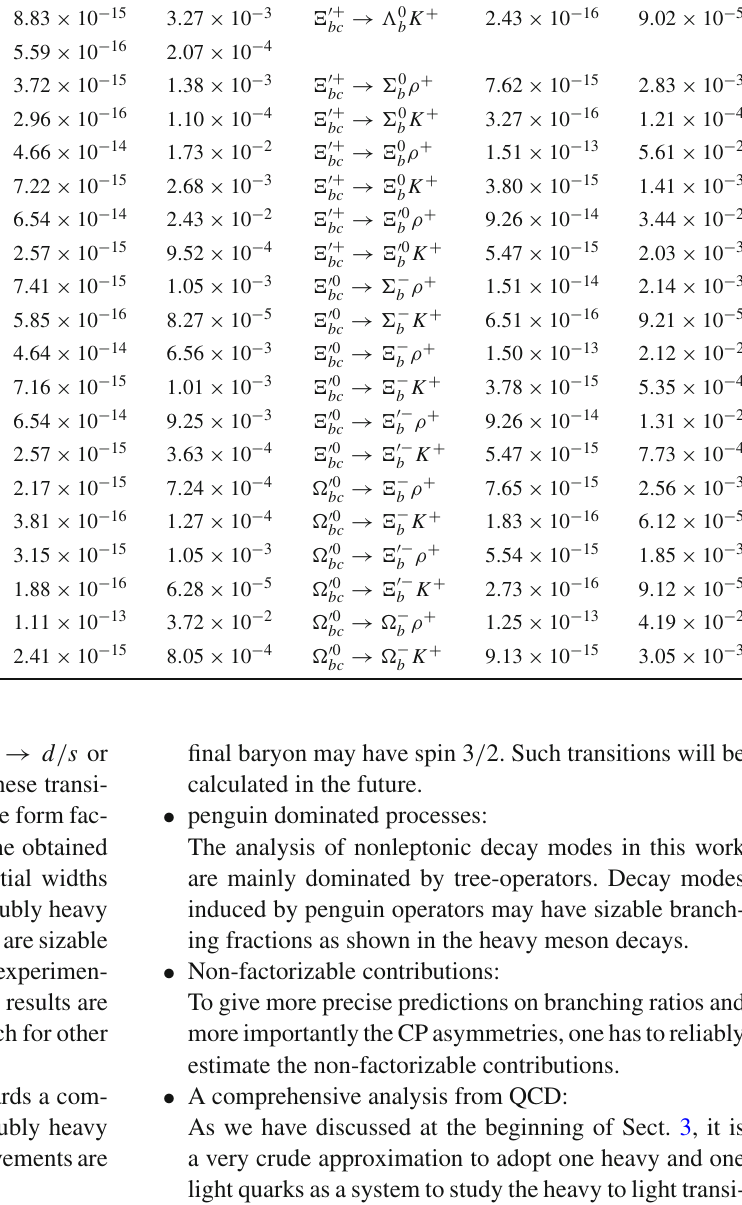
Table 27 Partial decay widths and branching ratios for nonleptonic charm decays of the bottom–charm baryons with scalar bc